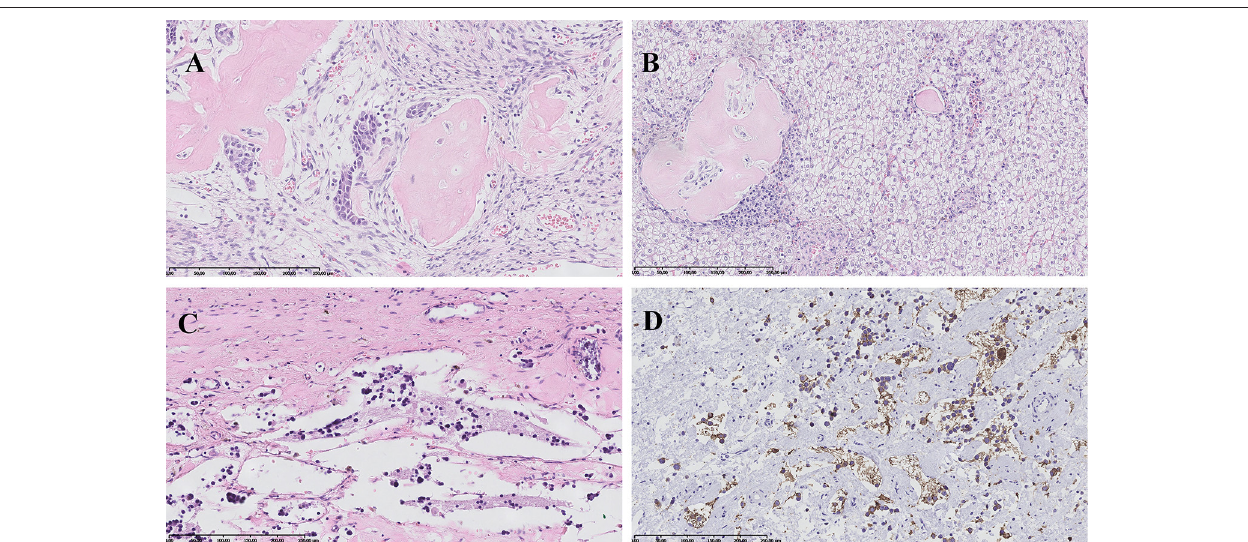
FIGURE 3 | Histopathological images. (A) Hepatoblastoma, mixed epithelial-mesenchymal subtype: areas of embryonal epithelial type cells, primitive mesenchyme and osteoid formation. HE, magnification 200x. (B) Hepatoblastoma, mixed epithelial-mesenchymal subtype: fetal epithelial type cells with focal extramedullary hematopoesis and mesenchymal component represented by osteoid formation. HE, magnification 200x. (C) Neuroblastoma, Schwannian stroma—poor, differentiating subtype: scant differentiating neuroblasts and neuropil in the background. HE, magnification 200x. (D) Neuroblastoma, Schwannian stroma—poor, differentiating subtype: positive immunohistochemical reaction for synaptophysin in tumor cells cytoplasm and neuropil. Magnification